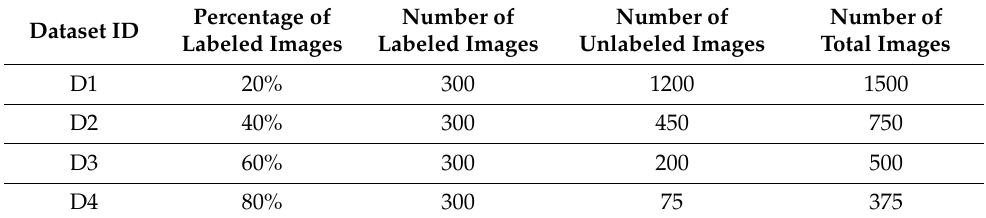
Table 3. Distribution of labeled samples on image datasets.